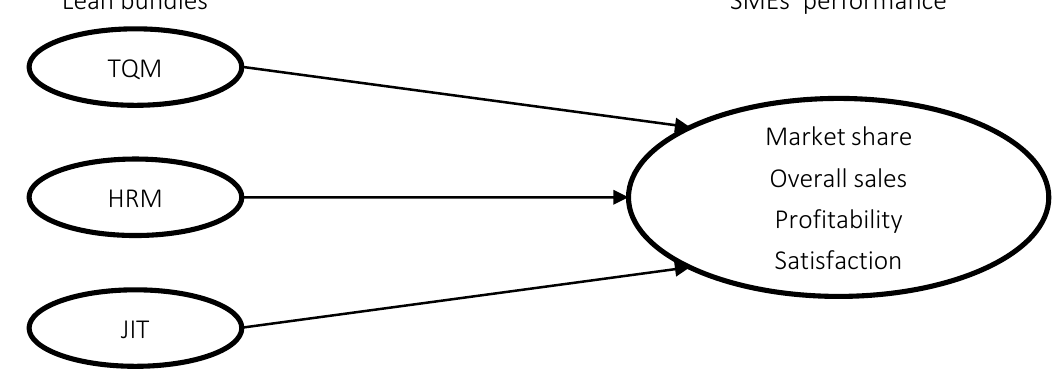
Figure 1. Research